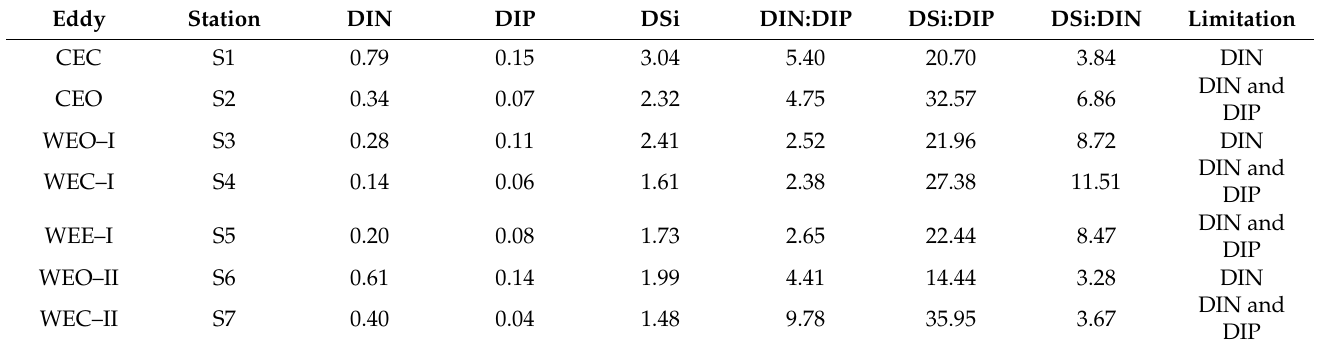
Table 3. Nutrient stoichiometry and limitation at all stations in the northwestern